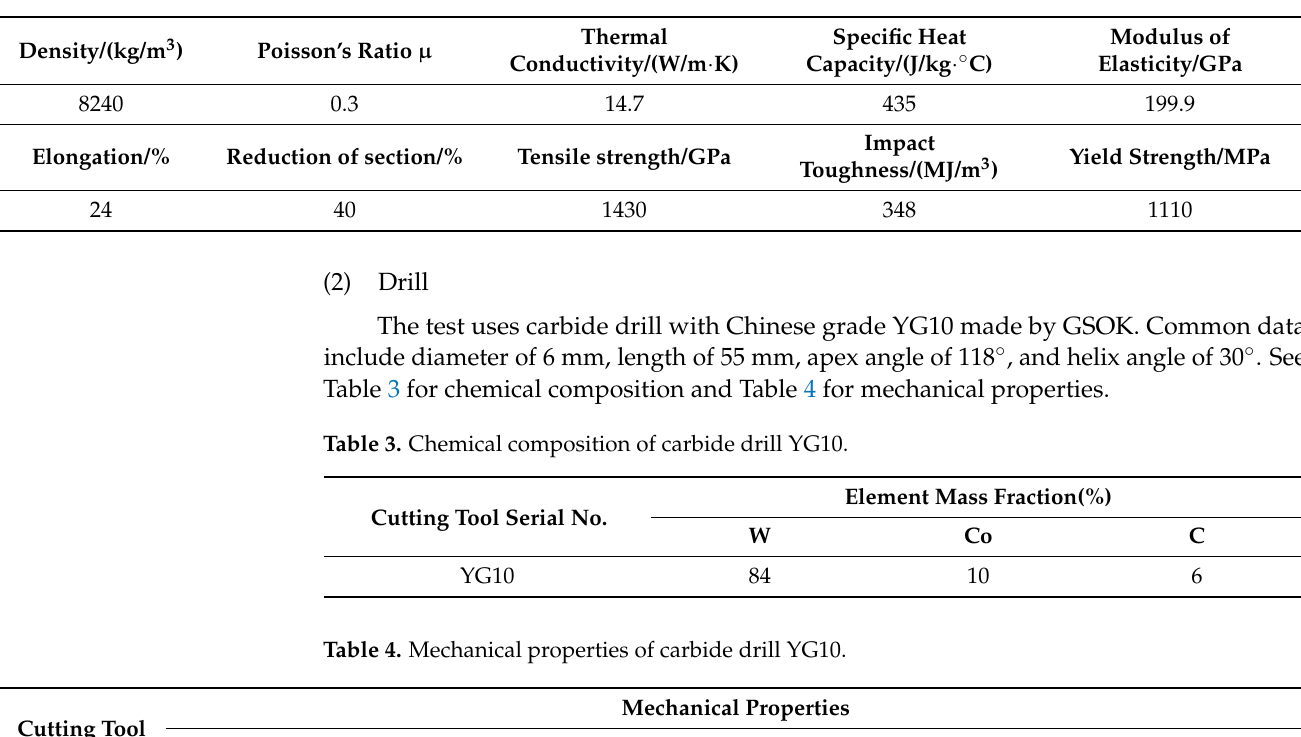
Table 2. Material properties of workpiece.